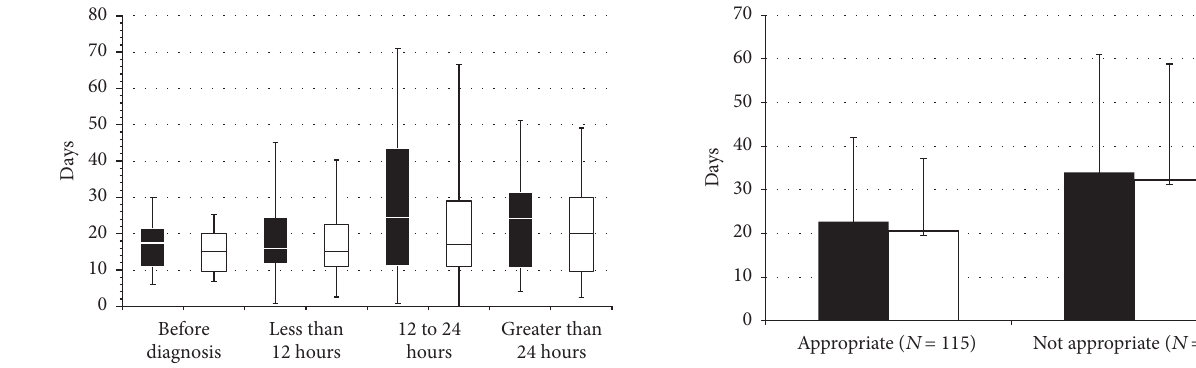
Figure 4: ICU length of stay and duration of mechanical ventilation relatedtoantibioticappropriatenessbasedoncultureresults.Overall trend for shorter ICU length of stay ( ◼ ; 𝑝 = 0.051 ) for those that received appropriate empiric antibiotic therapy when compared to the group that received inappropriate empiric antibiotics. Duration of mechanical ventilation ( ◻ ; 𝑝 = 0.13 ) was numerically but not significantly shorter in those who received appropriate empiric antibiotics. Data presented as mean ± standard deviation.